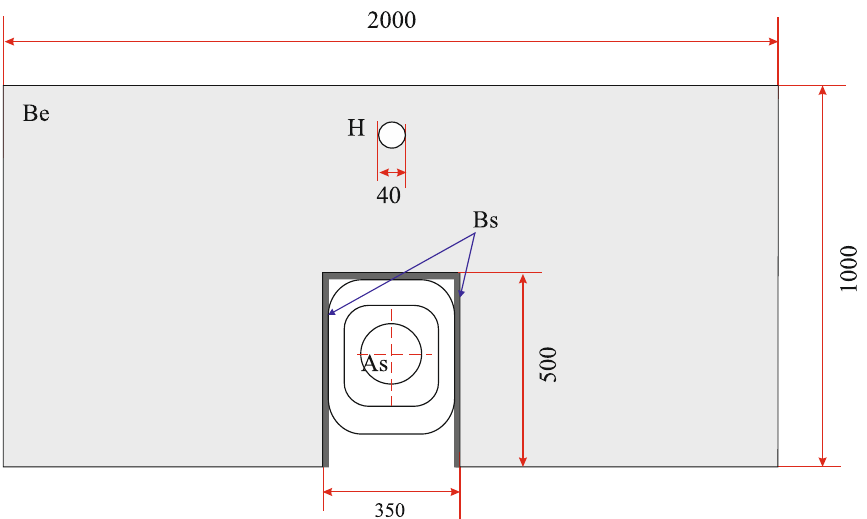
Figure 1. Schematic representation of the ballast. Be , ballast element; Bs , ballast support; As , axle-shaft; H , hooking hole. Unit: mm. Be thickness: 10 mm. Be mass: 138 kg.